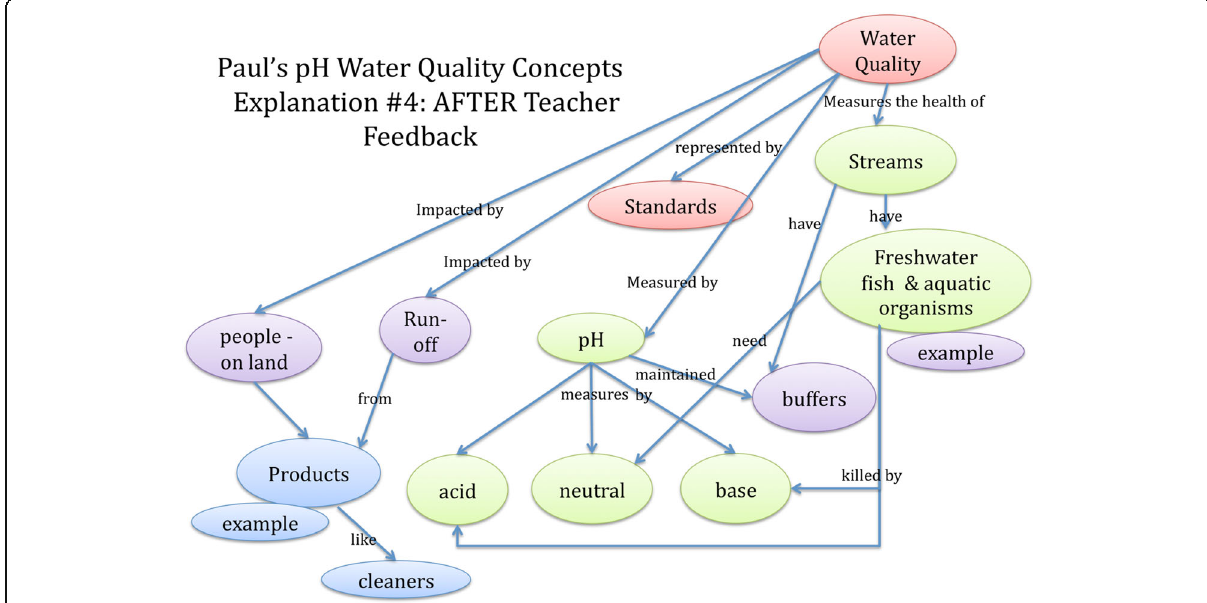
Fig. 5 Paul ’ s Explanation 4 (Ex4): Rubric Score - 6/6